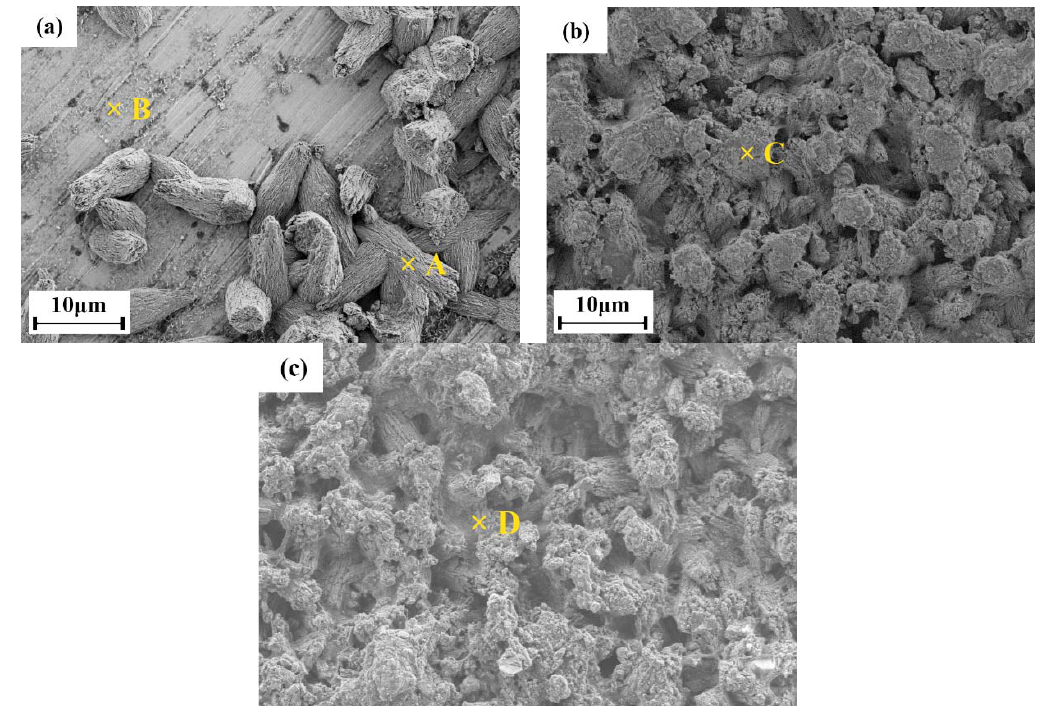
Figure 7. Surface morphology of 304 SS with polarization at − 0.80 V in sea water for 20 h ( a ), 70 h ( b ) and 168 h ( c ).